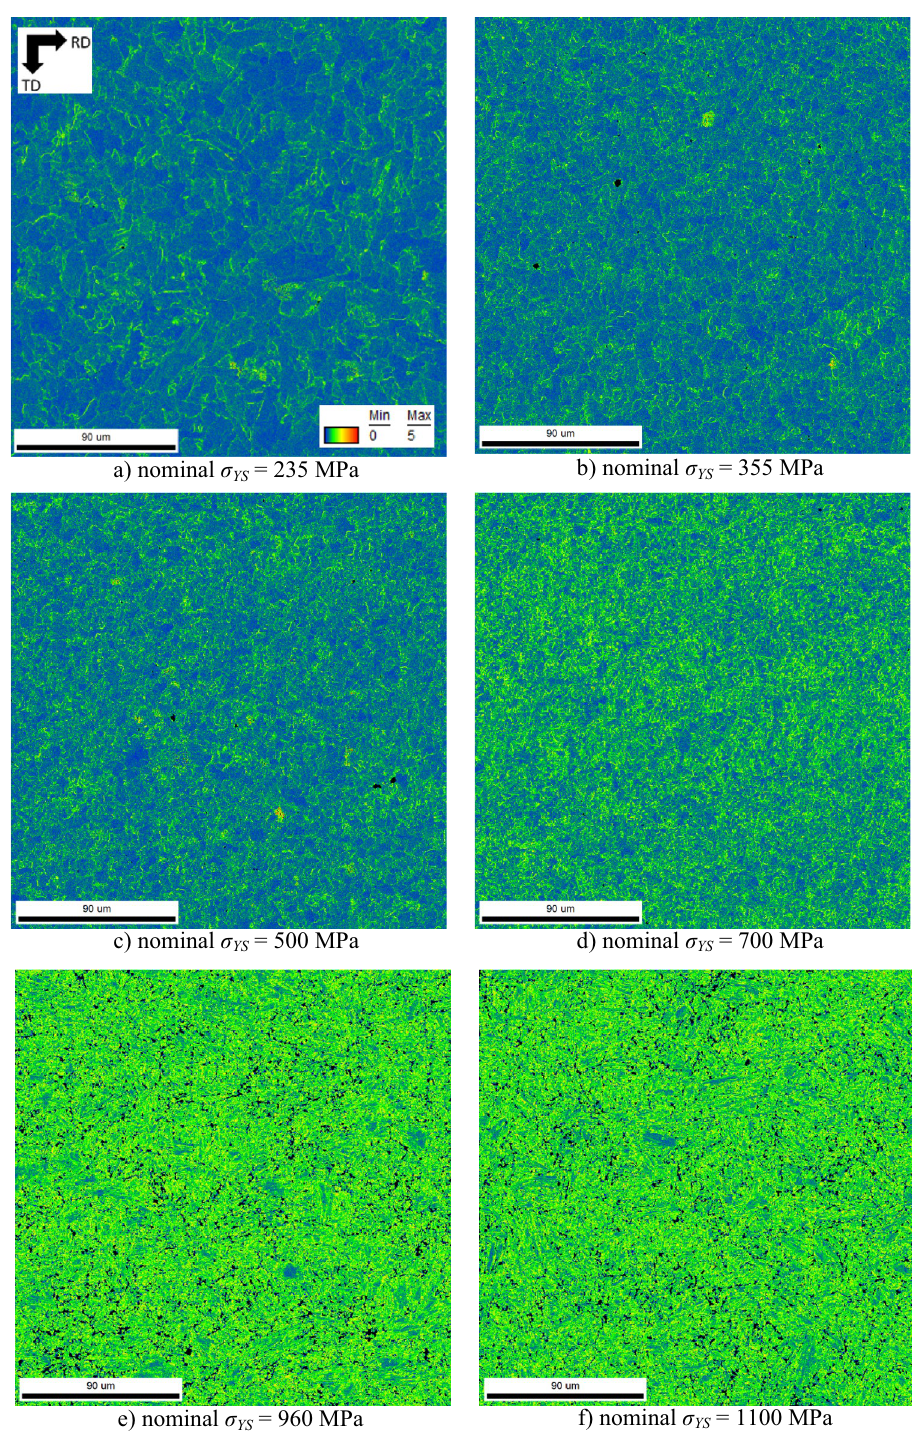
Figure 6. KAM maps,